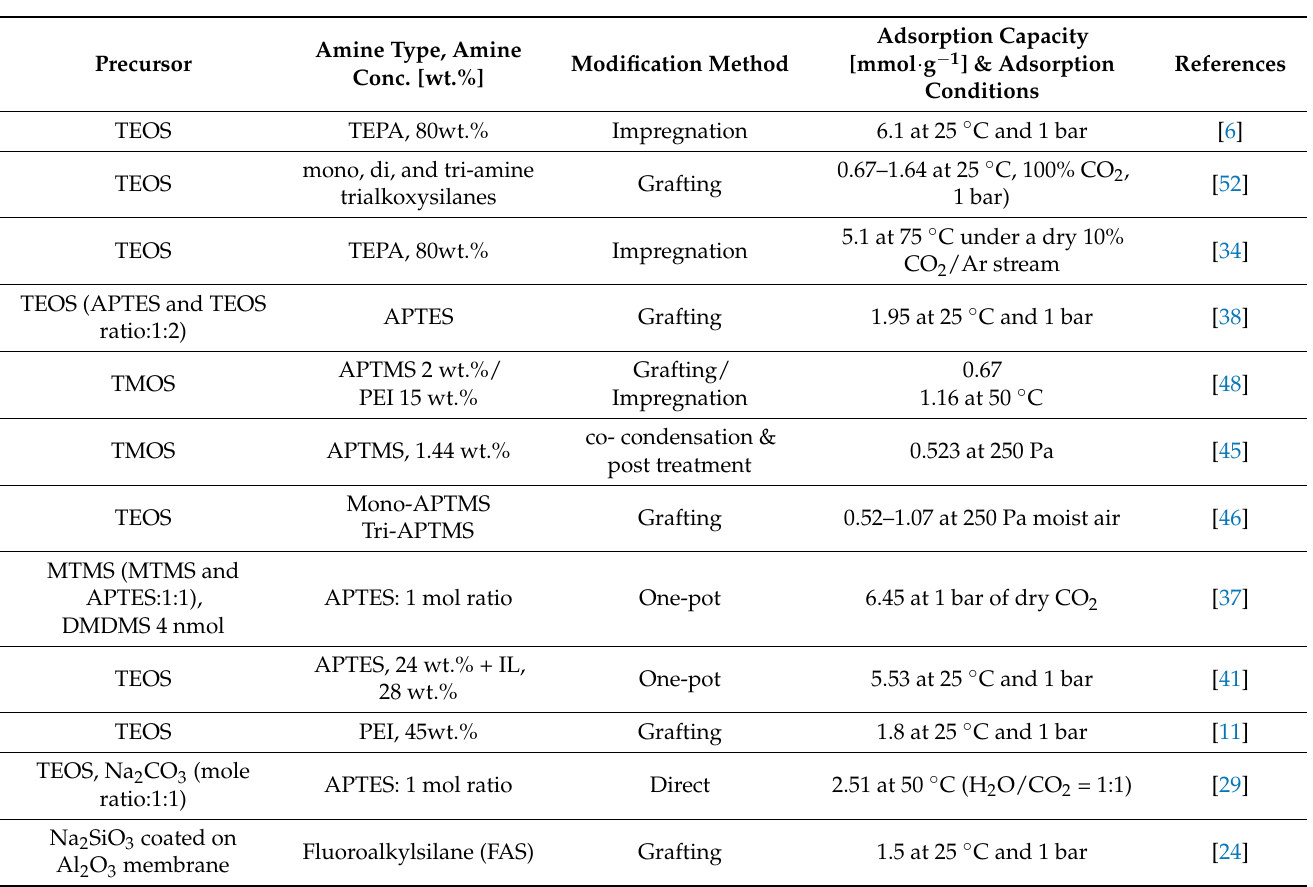
Table 1. Table 1. CO 2 capture by amine–silica